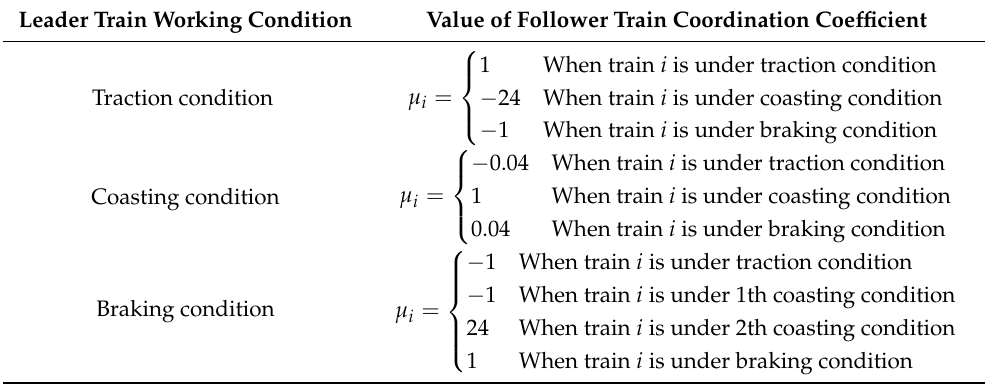
Table 1. Value of coordination